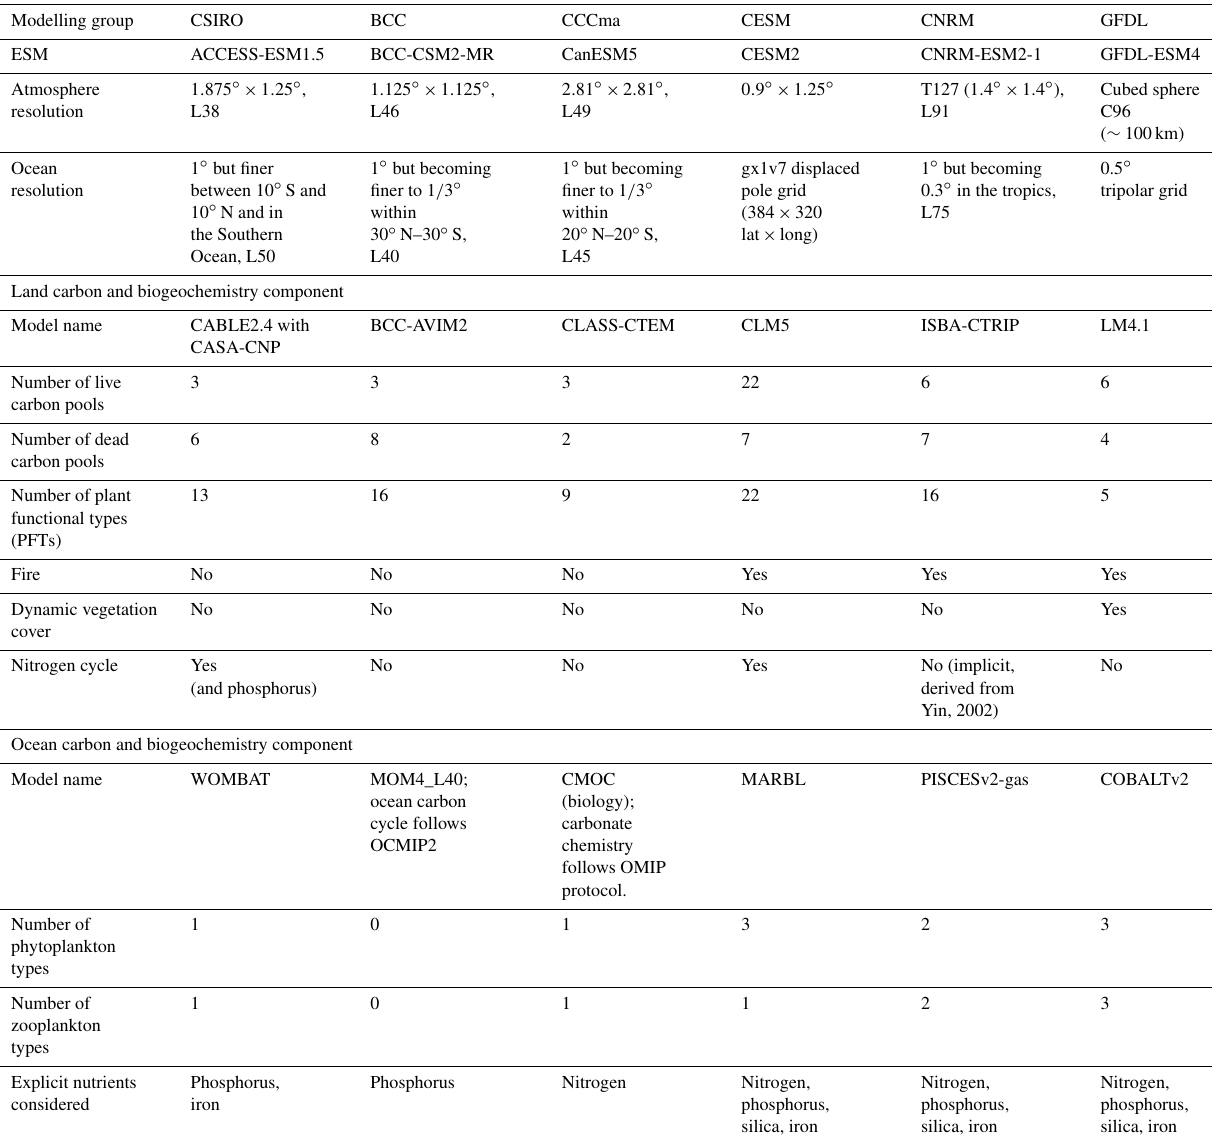
Table 2. Primary features of the physical atmosphere and ocean components and land and ocean carbon cycle components of the 11 partici- pating models in this